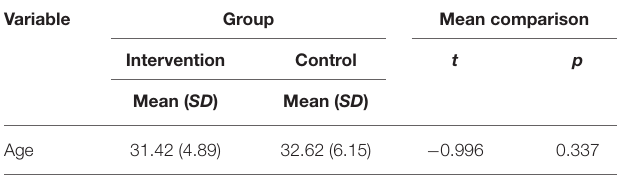
SD, Standard deviation.